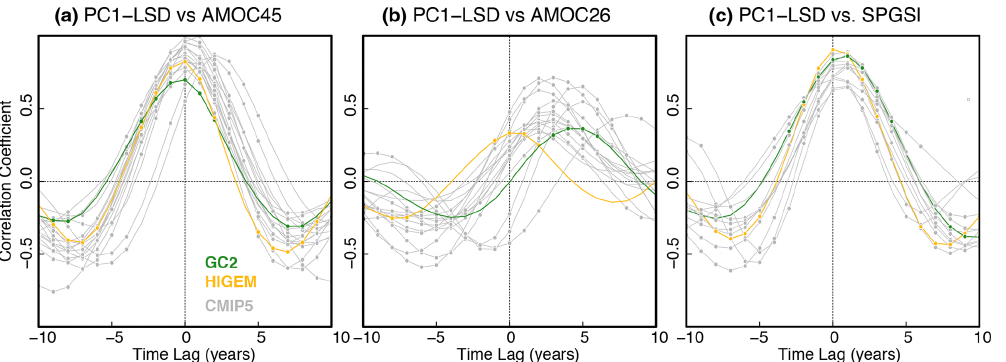
Figure 4. (a) Lead–lag correlations across the picontrol ensemble between the PC1-LSD index and the maximum AMOC streamfunction at 45 ◦ N after the Ekman transport is removed (AMOC45). Correlations are based on 10-year running trends. Significance is assessed as in Fig. 2d and is indicated with a circle. For positive lags, PC1-LSD leads. (b–c) The same as in (a) but between PC1-LSD and the maximum AMOC streamfunction at 26 ◦ N after the Ekman transport is removed (AMOC26) and the subpolar gyre strength index